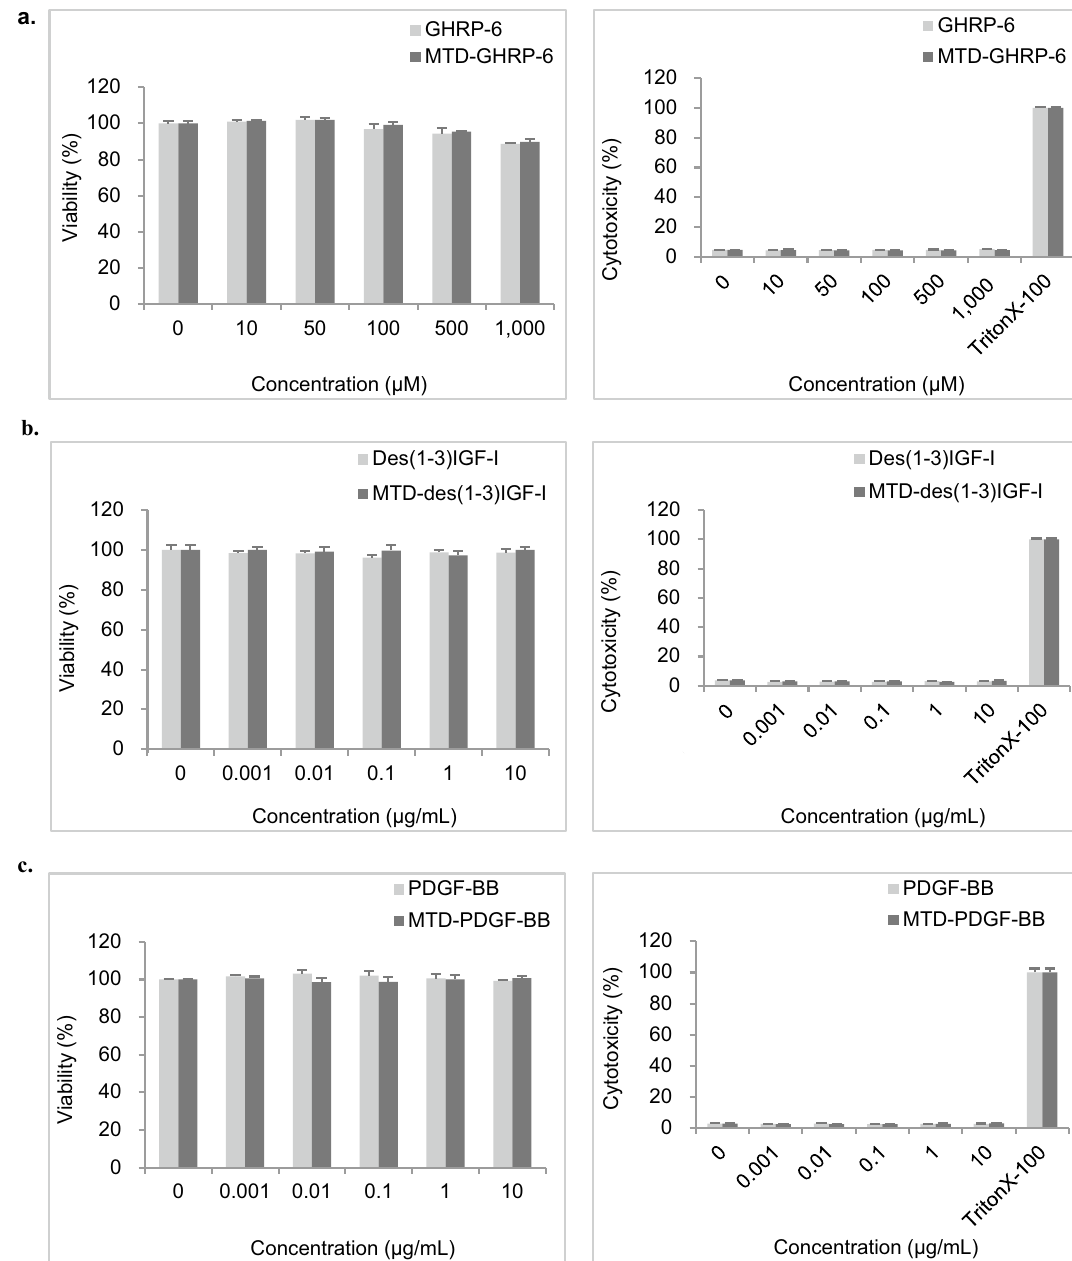
Figure. 7. Cell viability analysis using MTT assay (left panels) and cytotoxicity analysis using LDH assay (right panels) in HDFa cell. ( a ) GHRP-6 and MTD-GHRP-6, ( b ) des(1-3)IGF-I and MTD-des(1-3)IGF-I, ( c ) PDGF-BB and MTD-PDGF-BB. The μM concentrations correspond to 0, 8.7, 43.7, 87.3, 436.5 and 873 μg/mL for GHRP-6 and 0, 19.0, 94.9, 189.8, 949 and 1898 μg/mL for MTD-GHRP-6, respectively. Data are expressed as mean ± S.E. based on triplicates of at least two independent experiments. The results were expressed as % compared to the cell culture without treatment of the purified peptide or